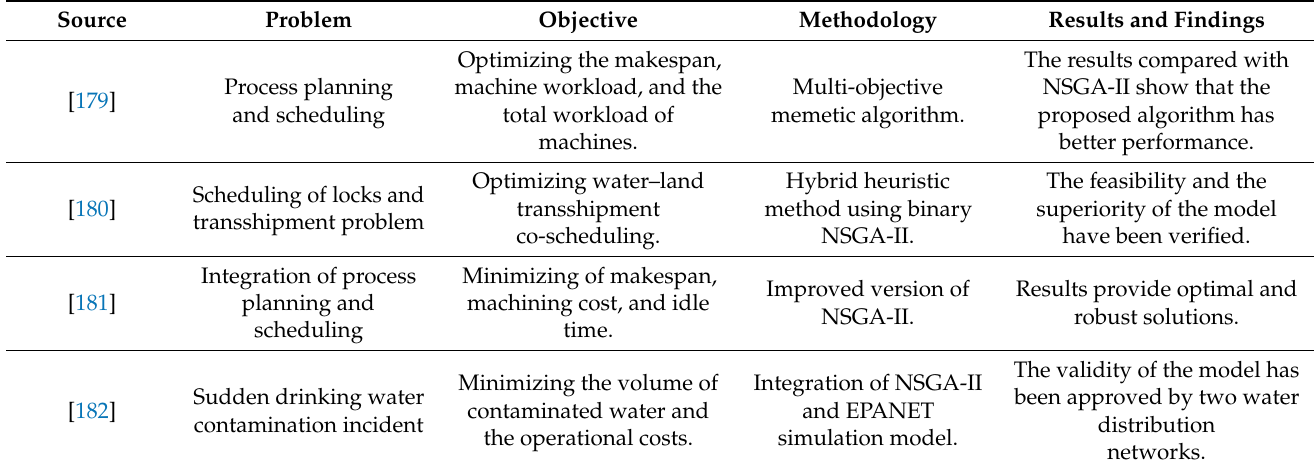
Table 7. Summary of the literature review on NSGA-II applications in different fields, along with methodology and